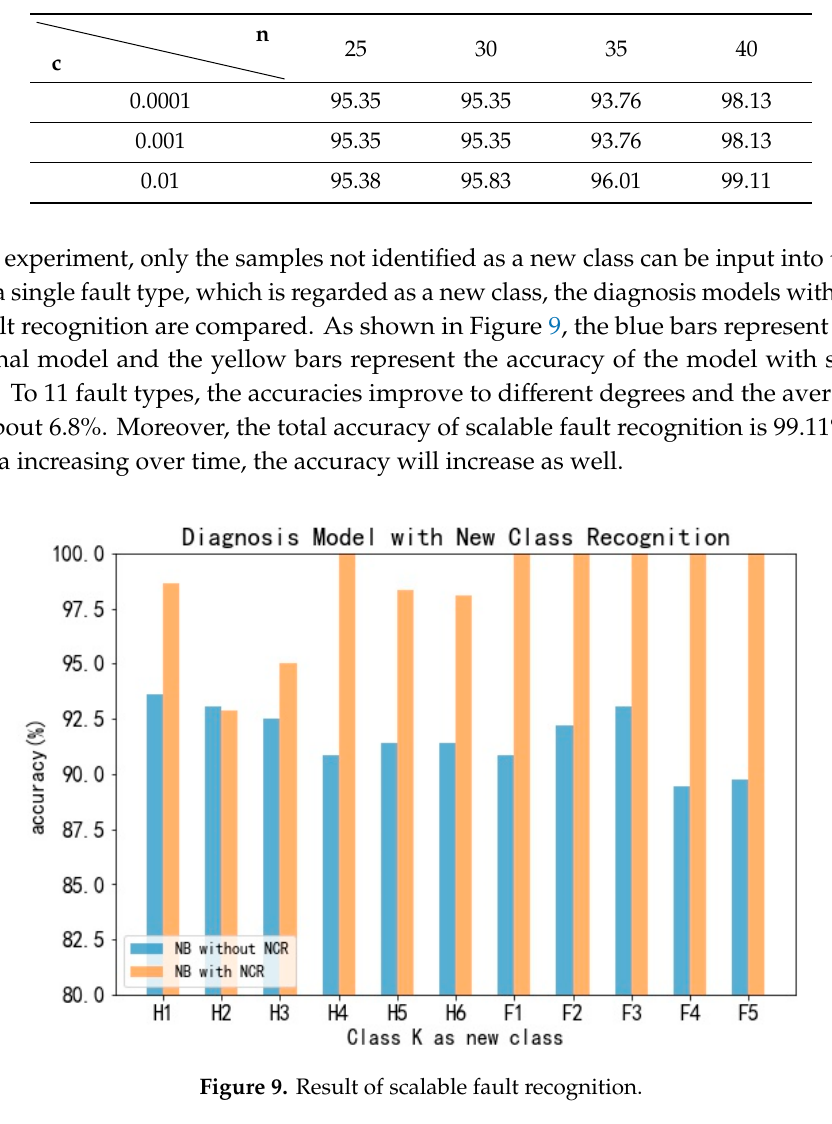
( b ) Figure 10. Comparison of original naïve Bayesian (NB) and incremental NB. ( a ) Comparison of training time; ( b ) comparison of classification accuracy. Table 3. Training time comparison (MS). Sample size